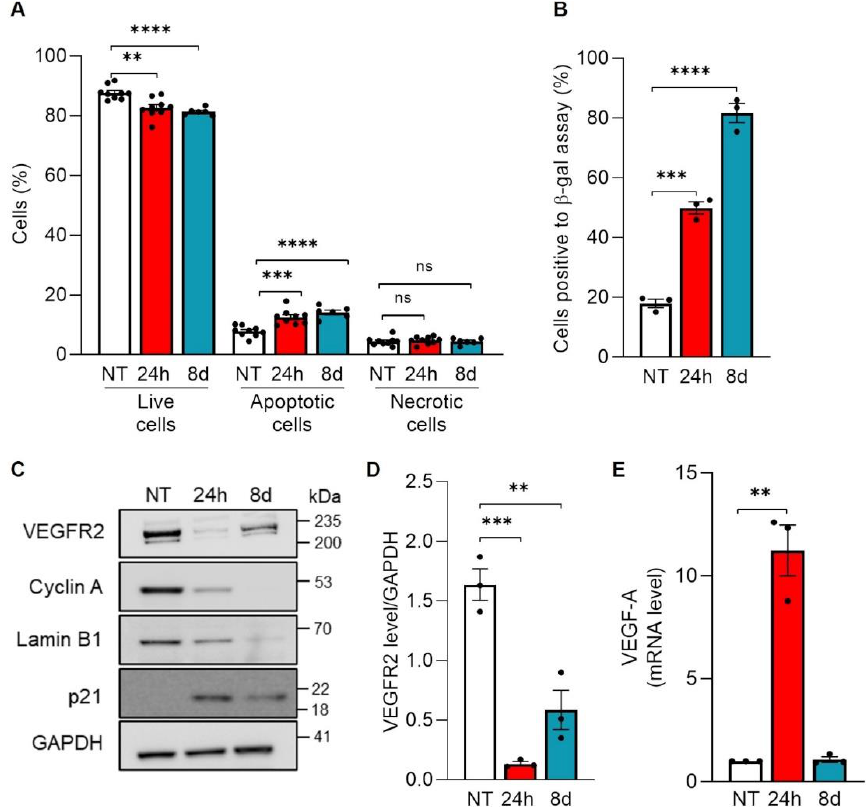
Figure 1. Effects of a transient exposure of endothelial cells to Doxorubicin. HUVECs were incubated with 250 nM Doxorubicin for 24 h. After extensive washing, the medium was replaced with free-drug complete medium and cells were maintained in culture for additional days. Samples were collected and analyzed at 24 h of treatment (24 h), red histogram, and after 8 days (8 d), blue histogram. NT = not treated cells, white histogram. ( A ) Percentage of live, apoptotic, and necrotic cells determined by cytofluorimetry. Data are shown as mean ± SEM of n = 6 – 9 independent experiments per condition. ns p >0.05, ** p < 0.01 *** p < 0.001, **** p < 0.0001 by unpaired Student’s t test. ( B ) Percentage of positive cells for Senescence- Associated β -galactosidase activity. Data are shown as mean ± SEM of n = 3 experiments per condition; *** p < 0.001, **** p < 0.0001 by unpaired Student’s t test. ( C ) Cell lysates analyzed by immunoblotting with the indicated antibodies. ( D ) Quantification of VEGFR2 protein level by densitometric analysis. Data are shown as mean ± SEM of protein level normalized to GAPDH. n = 3 independent experiments; ** p < 0.01, *** p < 0.001 by unpaired Stu- dent’s t test. ( E ) mRNA level of VEGF-A determined by qRT-PCR. Each sample was normalized to β -tubulin and data are expressed as fold increase compared to the untreated sample. Data are shown as mean ± SEM of n = 3 independent experiments per condition. ** p < 0.01.